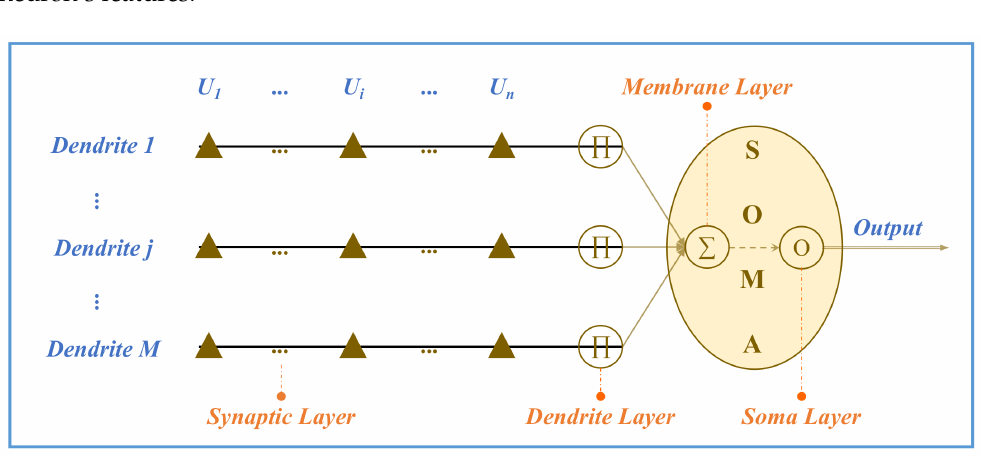
Figure 1. Dendritic neuron